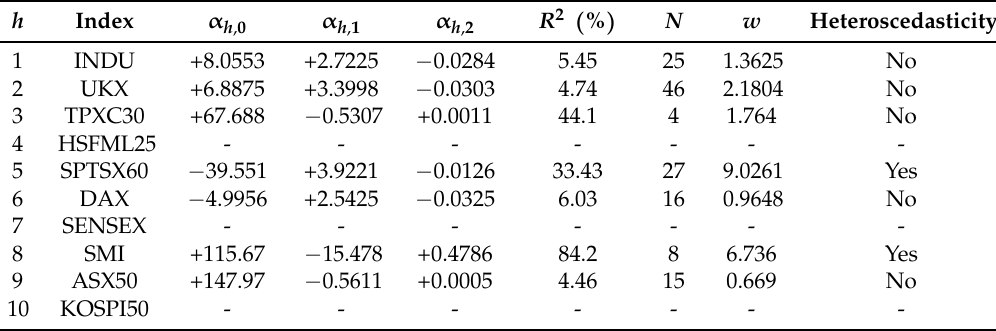
Table C2. White Test for Heteroscedasticity (95.0%) original data: